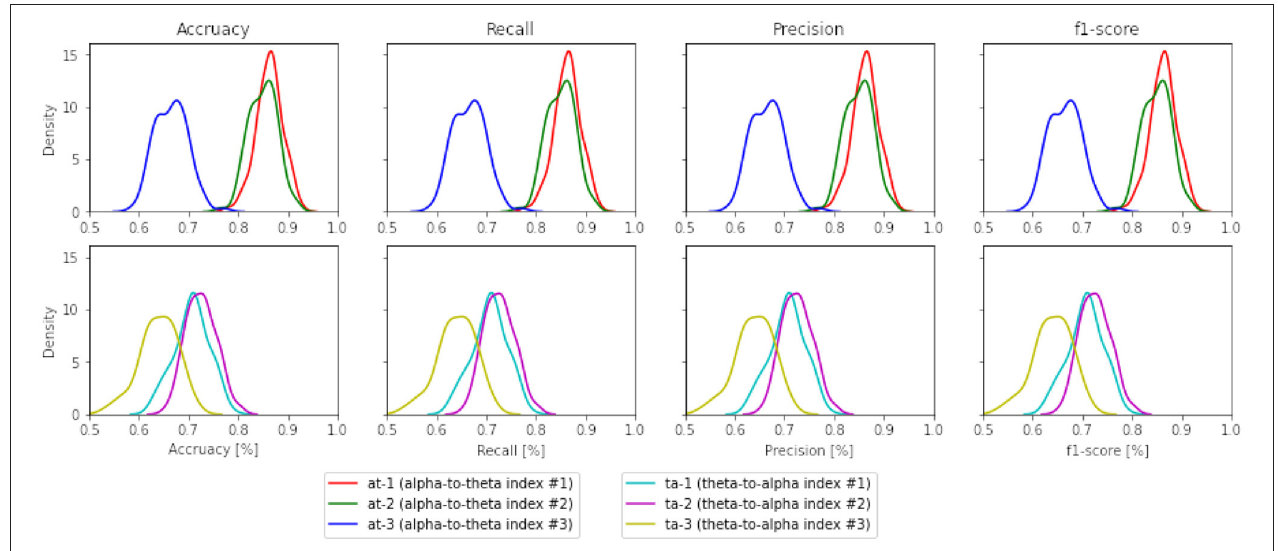
FIGURE 8 | Density plots across all performance metrics between all band ratio indexes (the case for SVM).